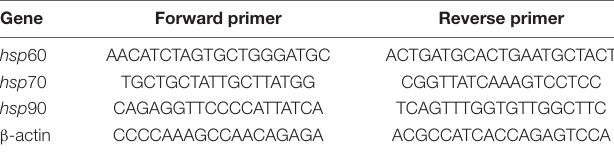
TABLE 1 | The forward and reverse primer sequences for each